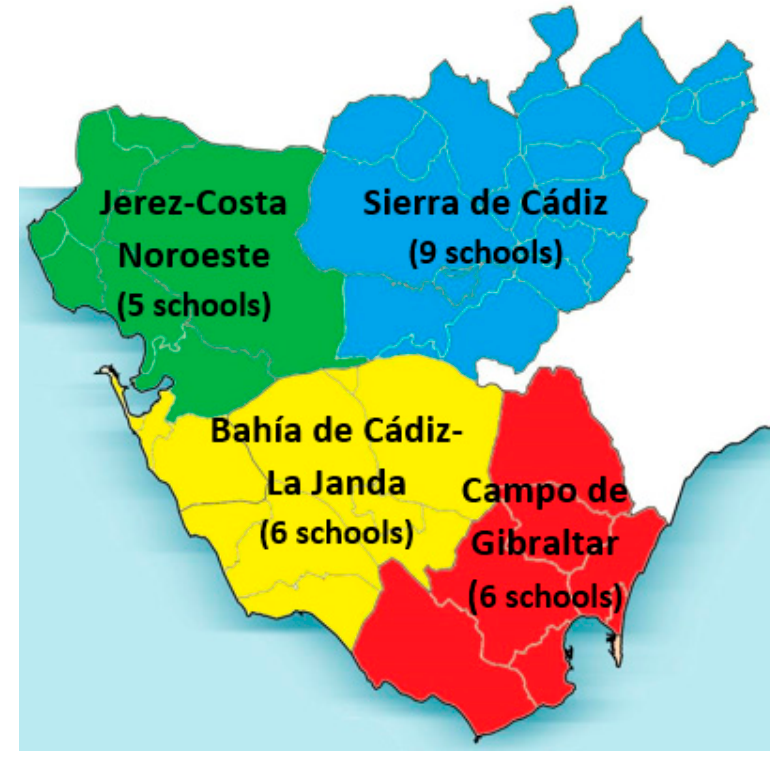
Figure 1. Geographical representation of the 4 study areas in the province of Cádiz.